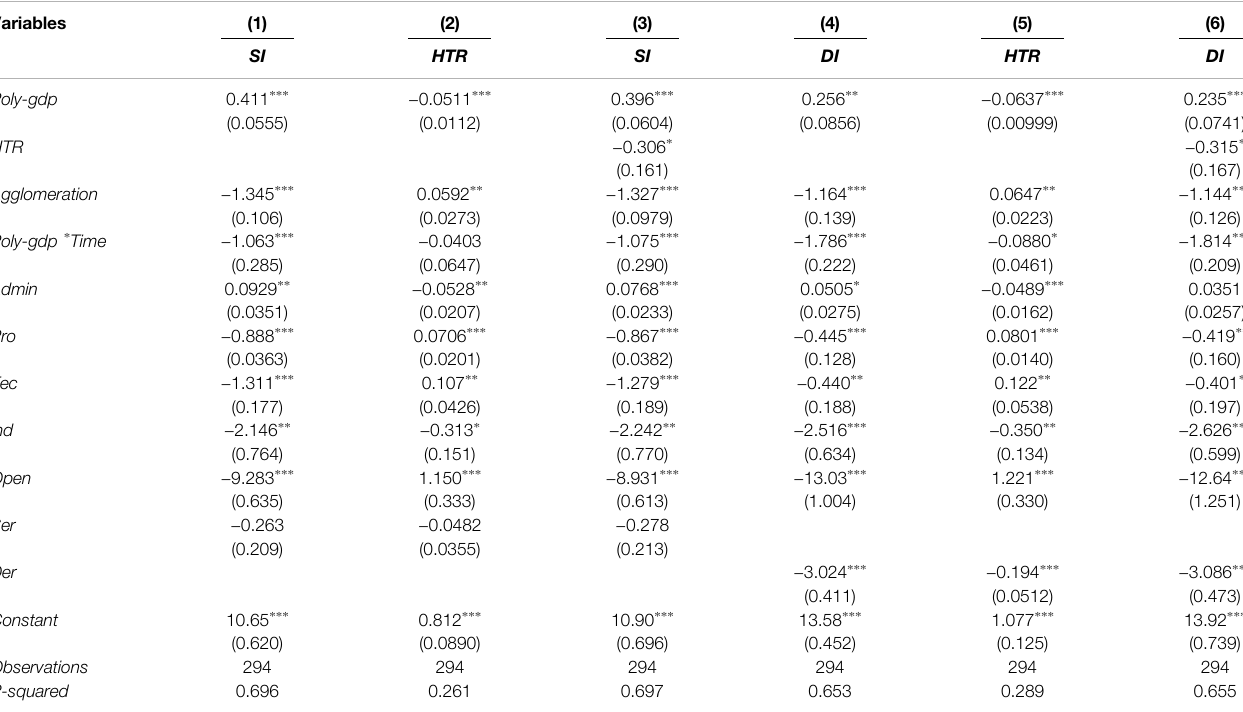
TABLE 9 | The mediating emission reduction effect of HTR